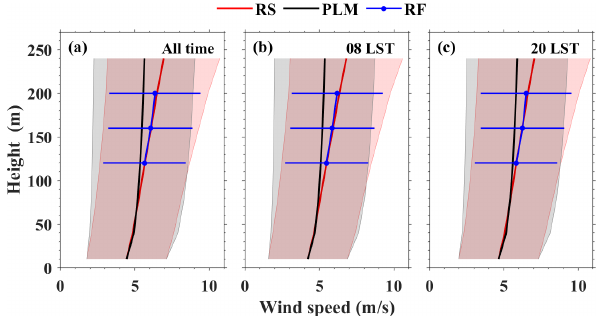
Figure 4. Vertical profiles of the wind speed from different meth- ods at (a) all times, (b) 08:00, and (c) 20:00LST. Red, black, and blue lines represent mean wind profile from RS, the PLM, and RF, respectively. Corresponding color shading areas represent the stan- dard deviation.